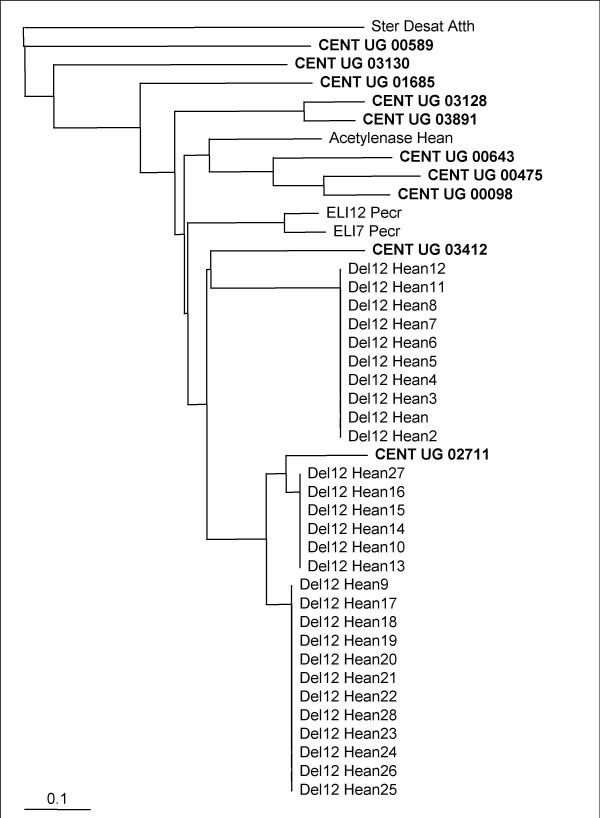
Phylogenetic analysis of acetylenease-related sequences from Centaurea cDNA library. C. maculosa EST sequences with similarity to fatty acid desaturase genes were clustered with previously characterized genes from Helianthus annuus (Hean), Petroselinum crispum (Pecr) fungal elicited desaturases (ELI), and with sterol desaturasase from Arabidopsis thalania as an outgroup. CENT_UG_00643, CENT_UG_00475, and CENT_UG_00098 cluster with the characterized acetylenase from H. annuus, distinct from the remaining Δ12 desaturases (Del12), suggesting potential for acetylenase activity.